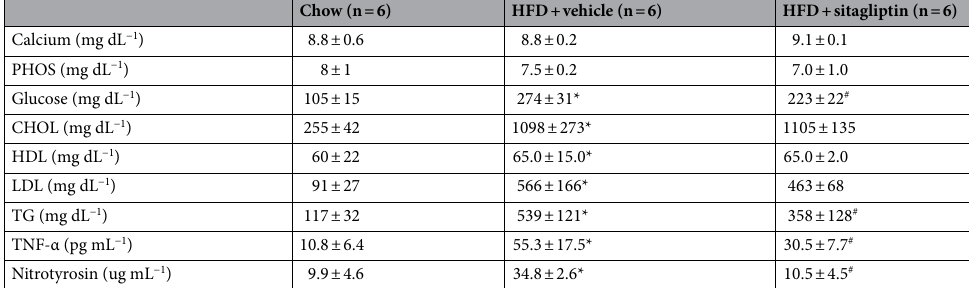
Table 1. Metabolic parameters after 24 weeks of dietary challenge and sitagliptin (100 mg/kg/day) treatment. Male LDLR −/− mice (n = 6 per group) were maintained on either mouse chow or HFD for 24 weeks and treated with either vehicle or 100 mg −1 kg −1 day −1 sitagliptin in vehicle. Data is presented as the mean ± SD. PHOS phosphate, CHOL cholesterol, HDL high-density lipoprotein cholesterol, LDL low-density lipoprotein cholesterol, TG triglyceride. * P < 0.05 vs. chow. # P < 0.05 vs.